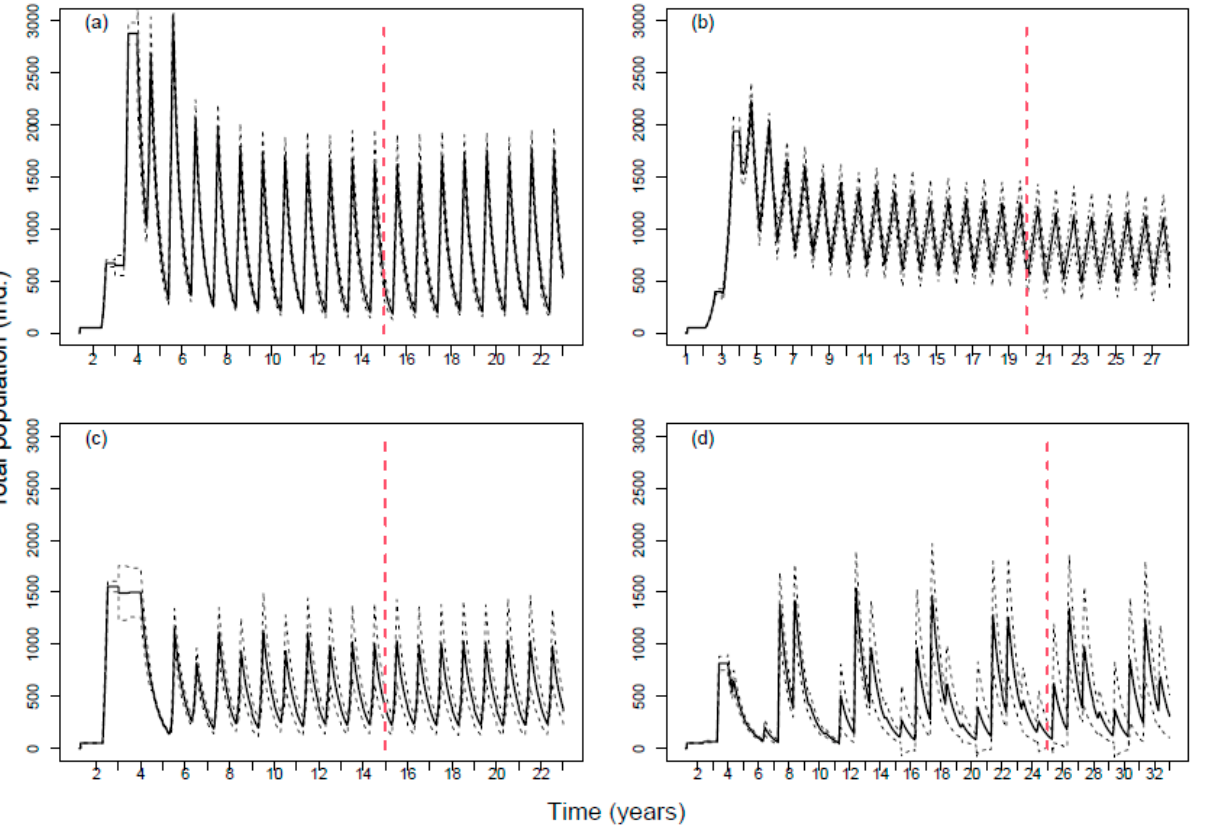
Figure 3. Population dynamics for the four species (without chemical effects). Solid lines show the average population abundance over 40 replicates. Dotted black lines define the standard deviation. The red dotted line shows when we added the effects of the exposure (populations completely stabilized). ( a ) Topeka shiner; ( b ) Devils River minnow; ( c ) Spikedace; ( d ) Humpback chub.